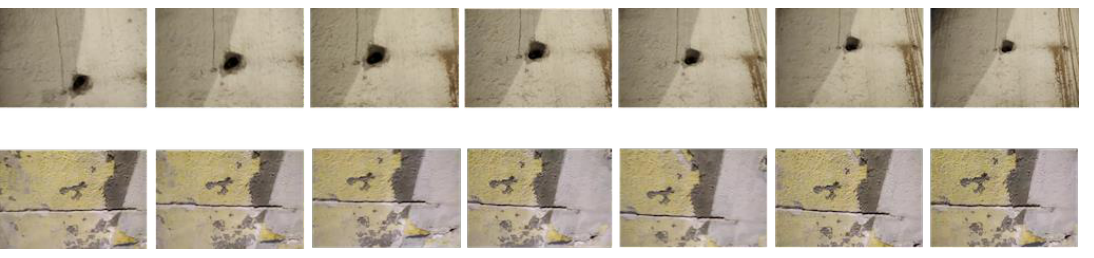
Figure 14. Visualization of data associated to an image of the evaluation dataset. As evaluation metrics, we used precision and recall (and their combination in F-measure). In addition, we also estimated the percentage of times that the recognition method needs operator